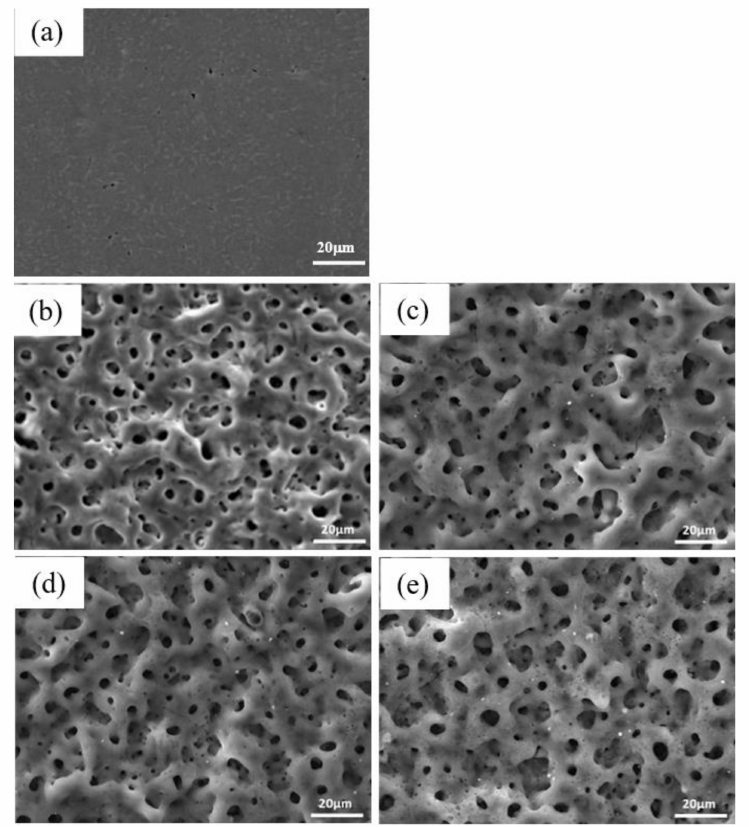
Figure 2. Surface morphologies of the ground TC4 alloy and the MAO coatings with different concentration of Si 3 N 4 /TaC particles: ( a ) TC4; ( b ) 0 g/L; ( c ) 1 g/L Si 3 N 4 + 0.5 g/L TaC; ( d ) 2 g/L Si 3 N 4 + 1 g/L TaC; ( e ) 4 g/L Si 3 N 4 + 2 g/L